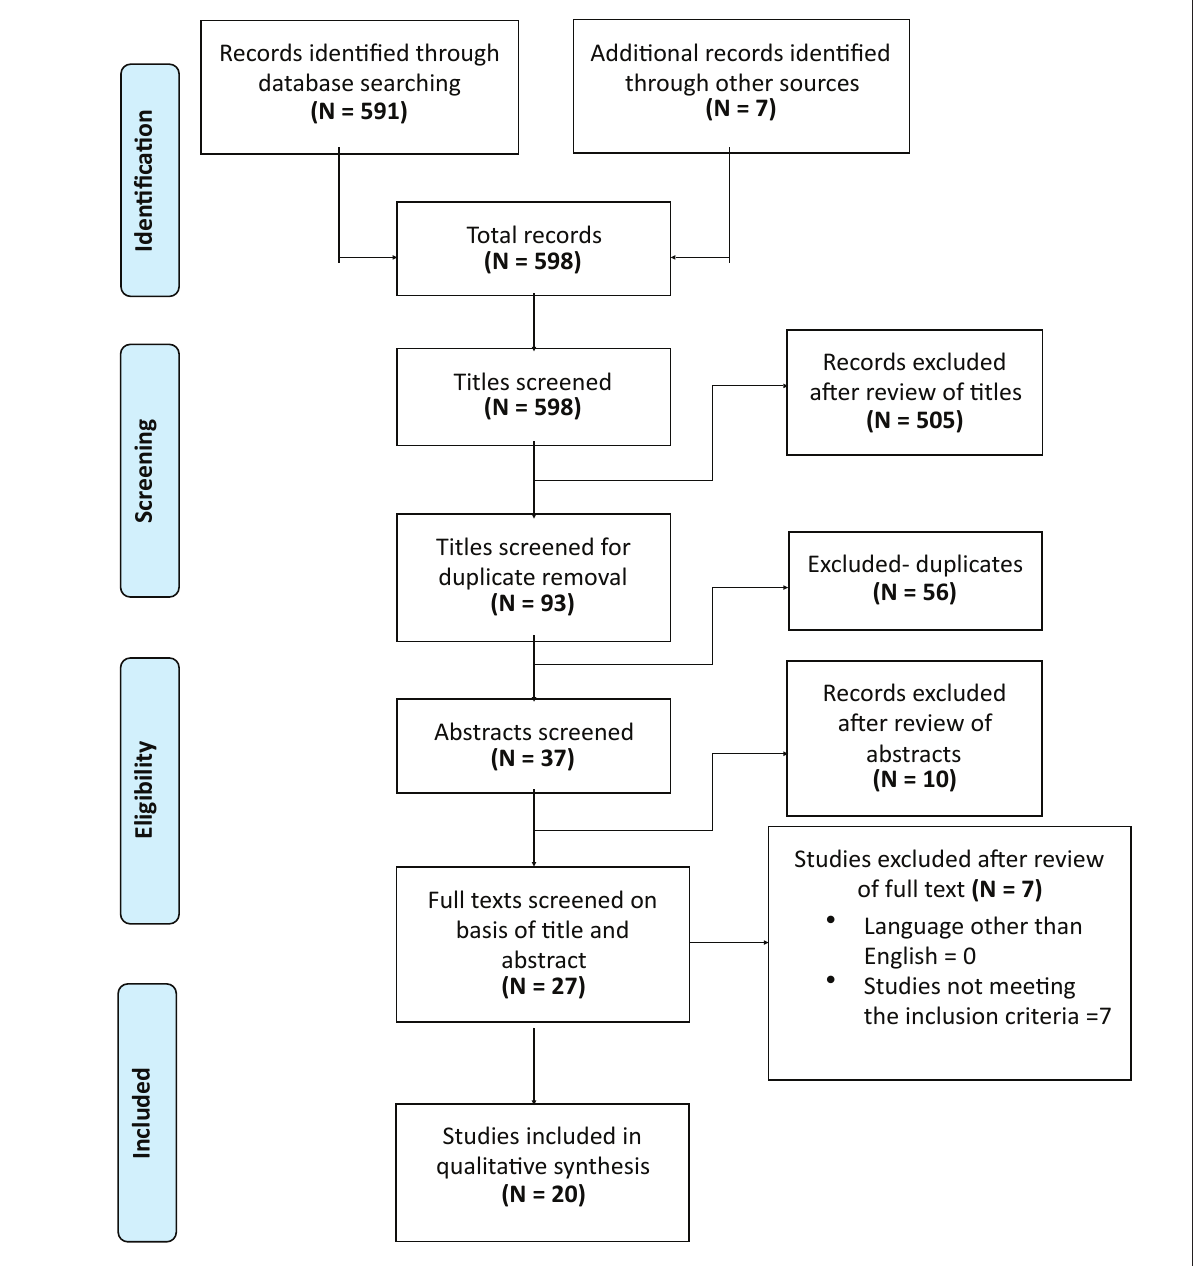
Figure 1. PRISMA 2009 Flow Diagram.